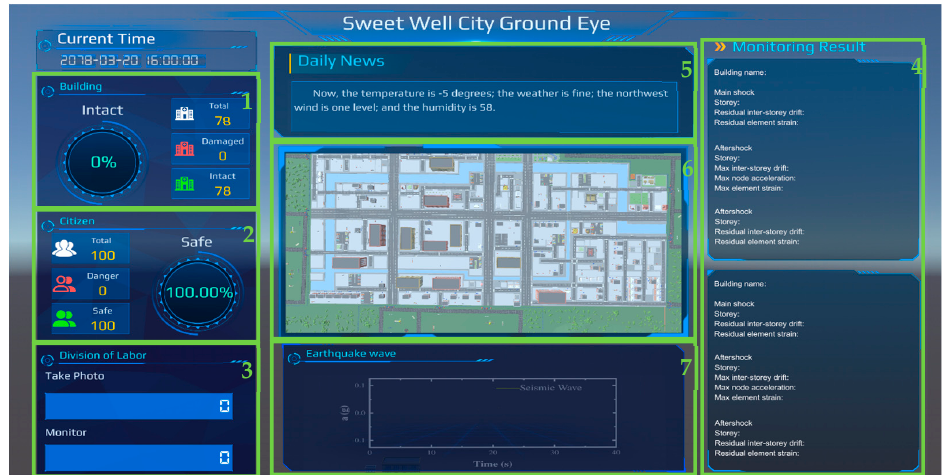
Figure 4. Ground Eye GUI.